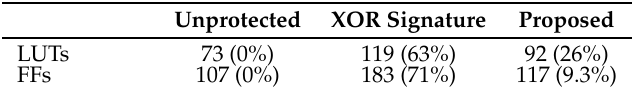
Table 3. Utilization Report (Parallel).